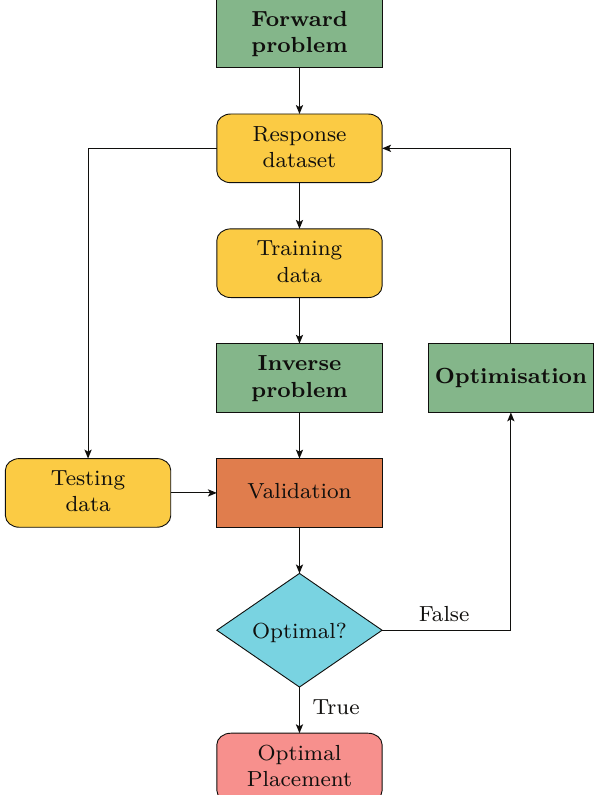
Figure 1. Proposed generalised methodology for optimising the sensor